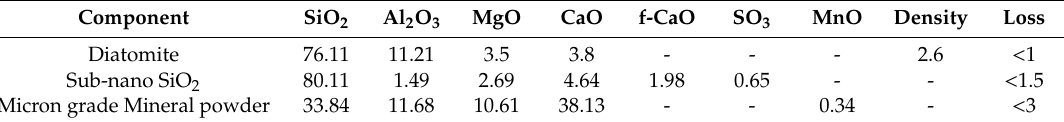
Table A1. Chemical constituents of Diatomite, SiO 2 and mineral powder (%).